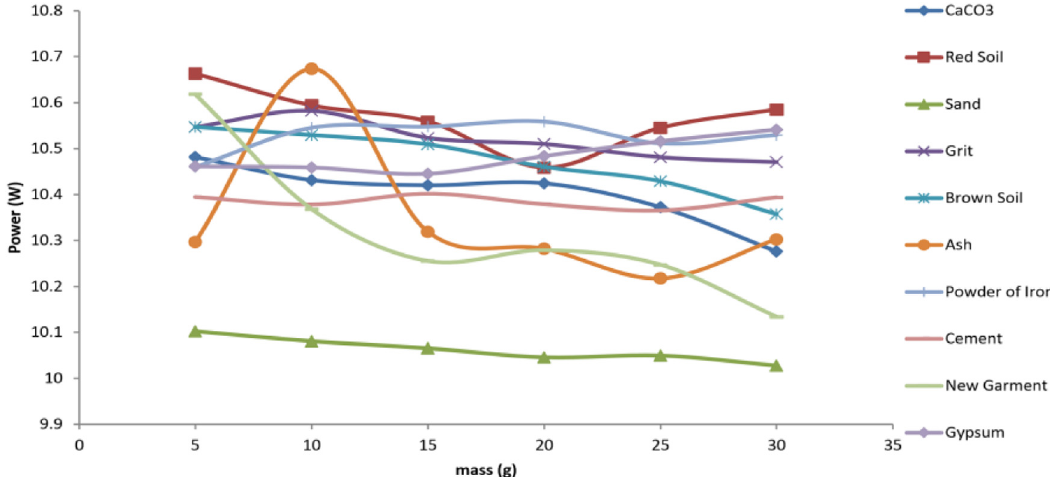
Fig. 4. Effect of changing the weight of the studied impurities accumulated on the voltage of PV